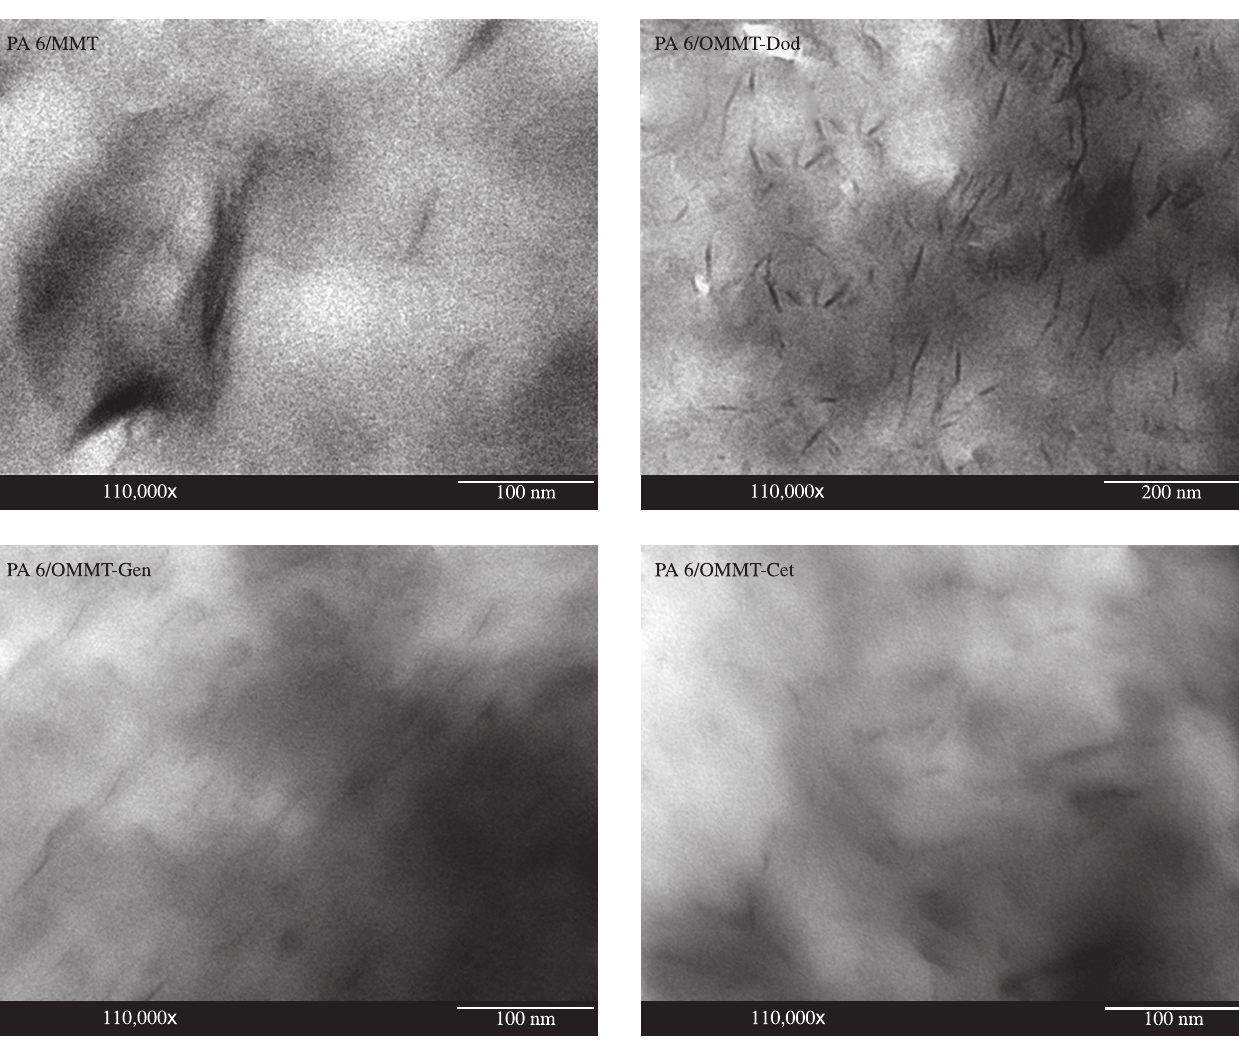
Figure 2. TEM photomicrographs of PA6/MMT, PA6/OMMT-Dod, PA6/OMMT-Gen and